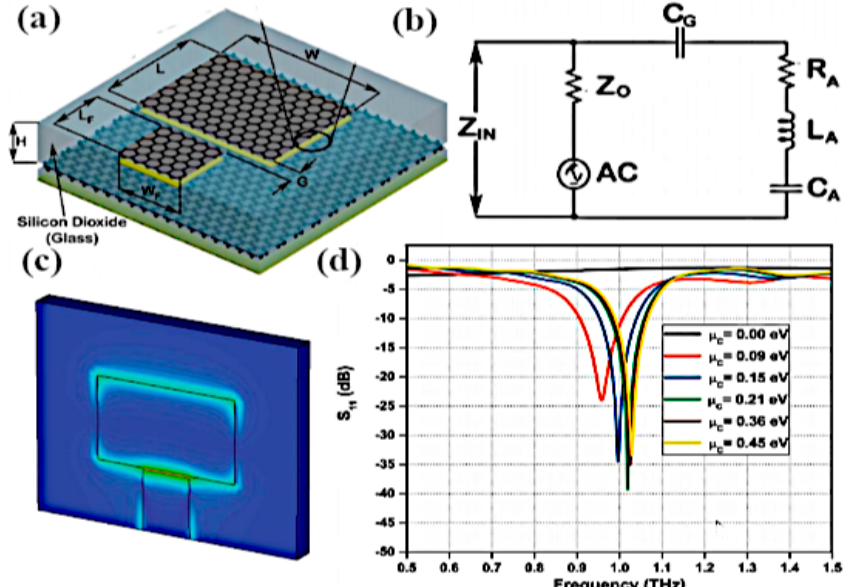
Figure 6. ( a ) Schematic of the graphene–metal hybrid antenna, where the graphene layer is inserted between quartz substrate and gold patches; ( b ) reflection coefficient hybrid antenna with respect to chemical potential; and ( c ) gain polar plots and changes in bandwidth by increasing the chemical potential. © 2016 IEEE. Reprinted from [110].